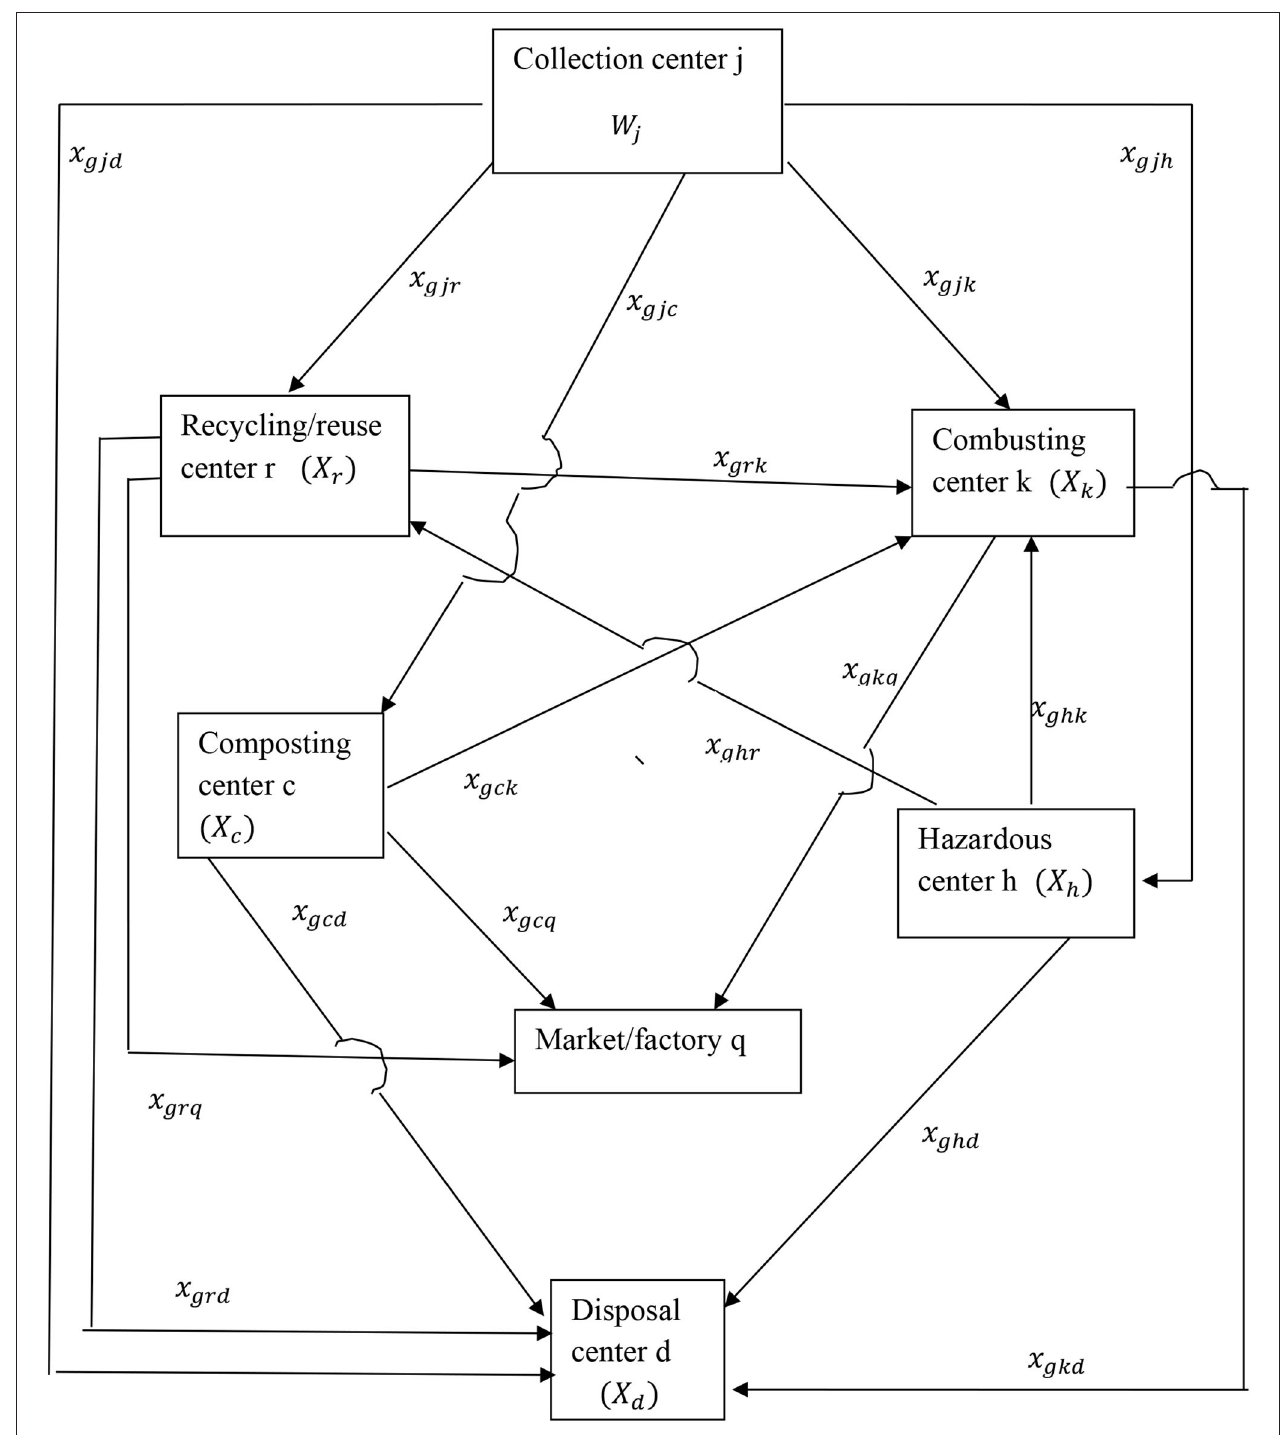
FIGURE 4 | The Schematic diagram of the proposed model for the MSWM system. Source: authors.